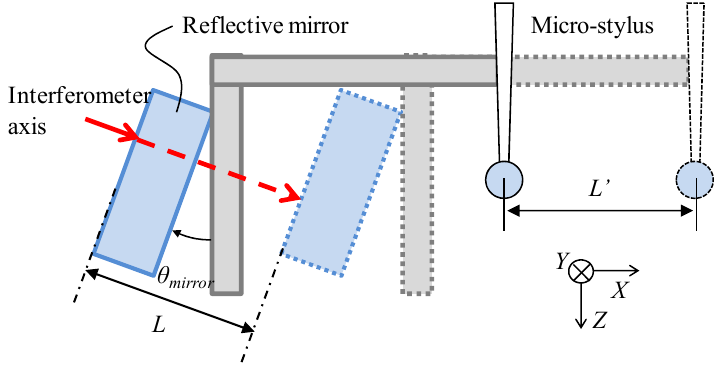
Figure 8. Schematic of the cosine error between the laser interferometer and the X ‐ directional moving axis.